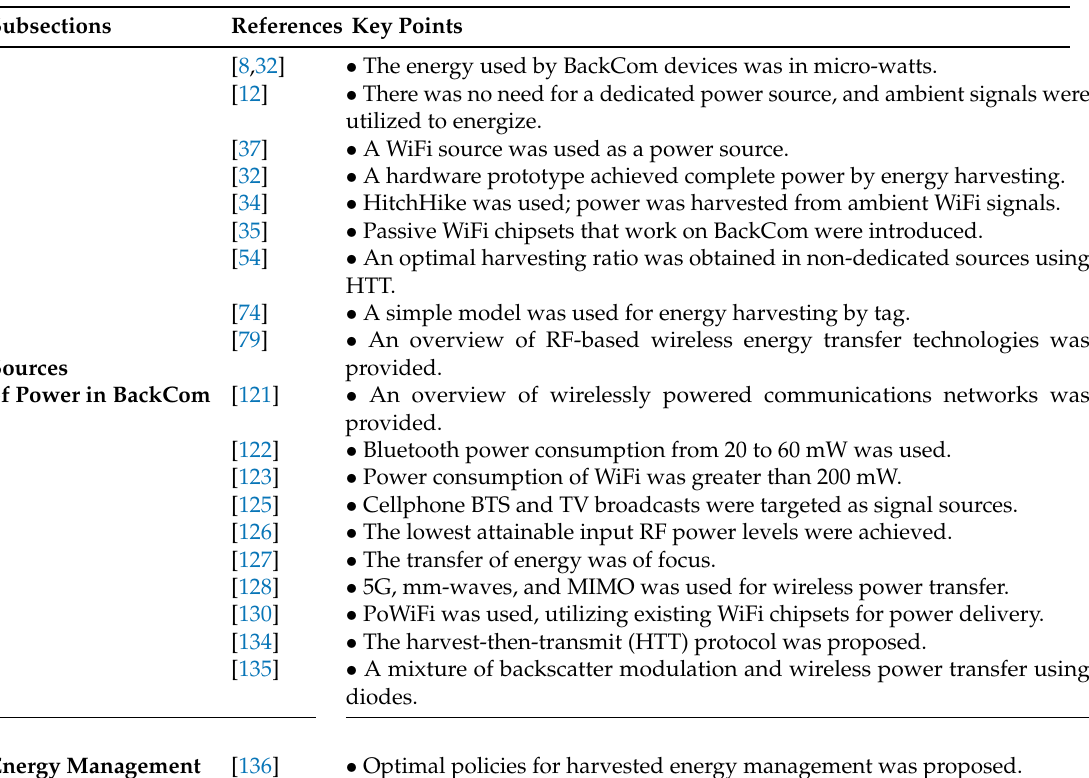
Table 9. Summary of BackCom efficient power and data